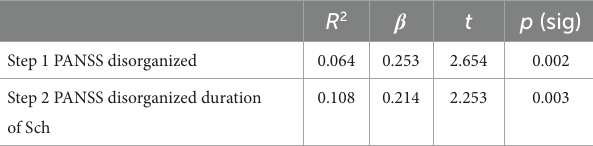
TABLE 4 Relationship between OCS with the onset of schizophrenia and its